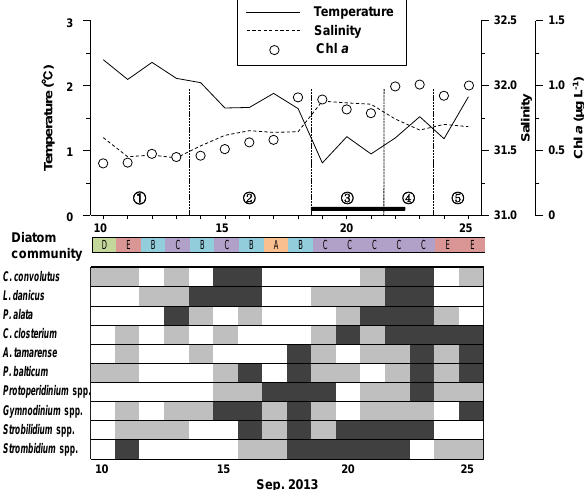
Figure 7. Schematic diagram of temporal changes in environmen- tal parameters (upper panel), diatom community (middle bar) and abundance of dominant microplanktonic species (lower panel) at a water column of a single station in the Chukchi Sea from 10 to 25 September 2013. Values of the upper panel indicate integrated mean data. The solid bar indicates the timing of a strong wind event. Black, grey and white in the lower panel indicate relative abundance – high, middle and low, respectively – of each species in a 0 to 30m column of water. Based on a dominant community and species, tem- poral changes in a microprotist community were divided into five phases, which are indicated by the circled numbers (1 to 5) and dashed lines in the upper panel. For details, see